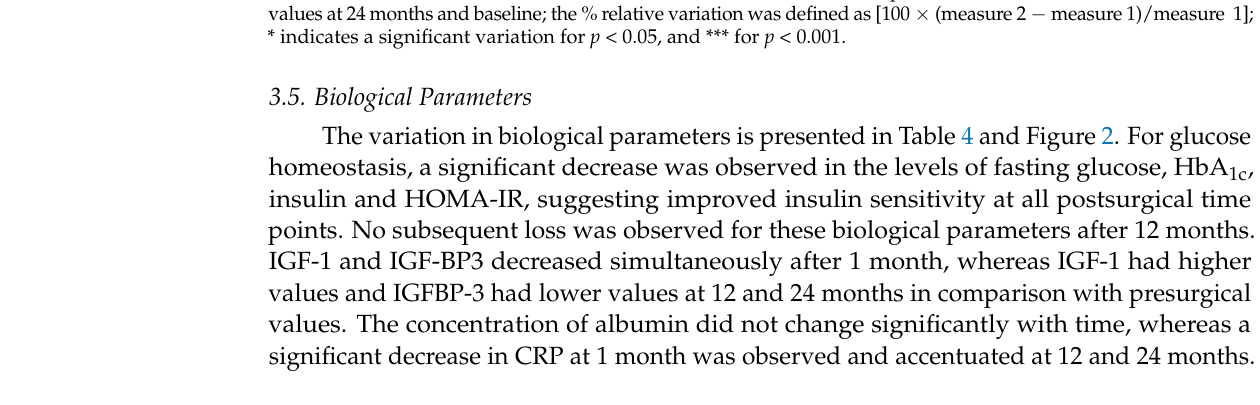
Table 4. Biological parameters at baseline and 1, 12 and 24 months after sleeve